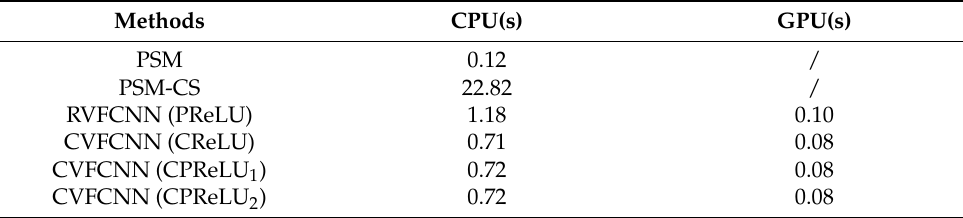
Table 4. Processing-time comparison on the testing